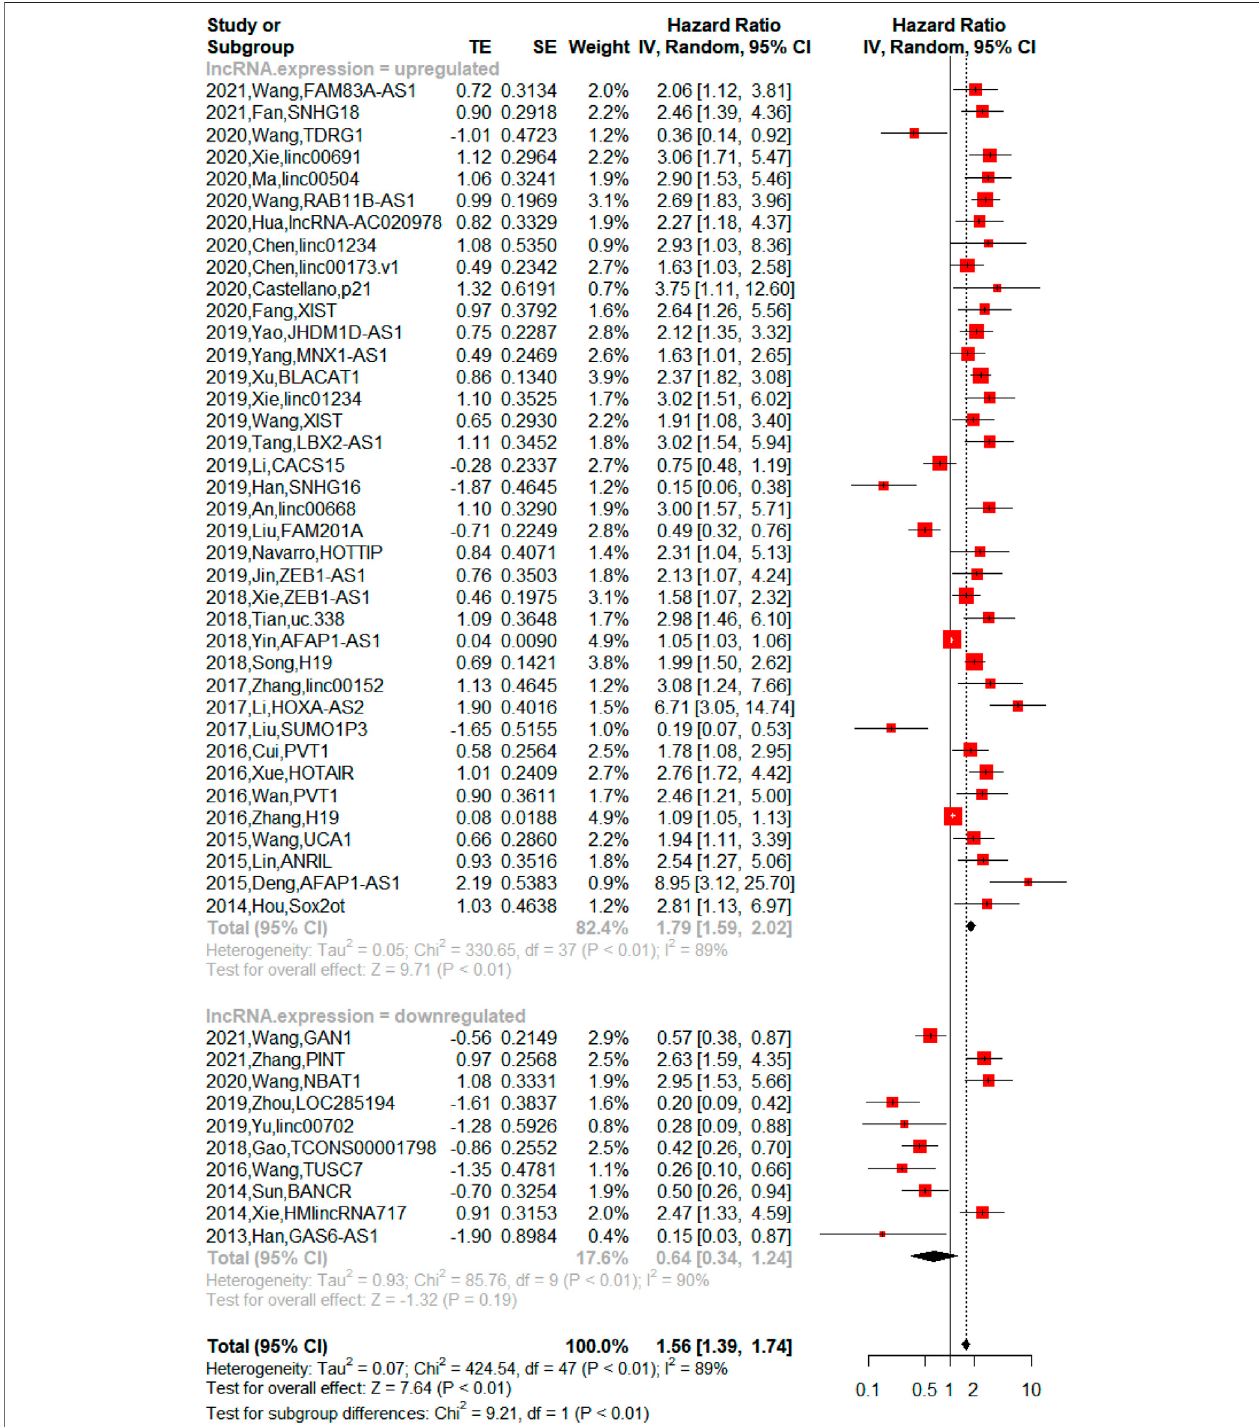
FIGURE 4 | Forest plots of hazard ratio (HR) for association between lncRNA expression and overall survival [There was heterogeneity between the upregulated lncRNA group and downregulated lncRNA group ( p < 0.01). The upregulated lncRNAs indicated shorter overall survival (OS) in NSCLC ( p < 0.01), and downregulated lncRNAs showed no signi fi cant association with OS in NSCLC ( p = 0.19)].